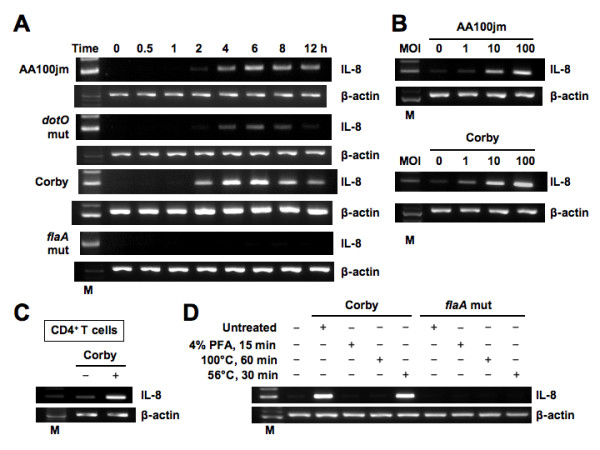
L. pneumophila-induced IL-8 mRNA expression in T cells. (A) Total RNA was extracted from Jurkat cells infected with AA100jm, dotO mutant, Corby, or flaA mutant (MOI of 100) for the indicated time intervals and used for RT-PCR. (B) Jurkat cells were infected with the indicated concentrations of L. pneumophila for 4 h. Total RNA was extracted and used for RT-PCR. (C) Total RNA was extracted from CD4+ T cells infected with Corby (MOI of 50) for 3 h and used for RT-PCR. (D) Jurkat cells were infected with live L. pneumophila Corby or flaA mutant (MOI of 100) for 4 h or incubated with L. pneumophila under the indicated treatment for 4 h. PFA, paraformaldehyde. Total RNA was extracted and used for RT-PCR. Representative examples of three experiments with similar results.